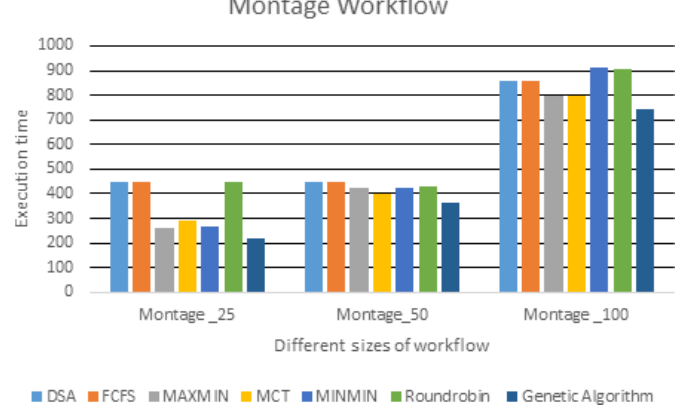
Fig. 10. Execution time required for montage work°ow using